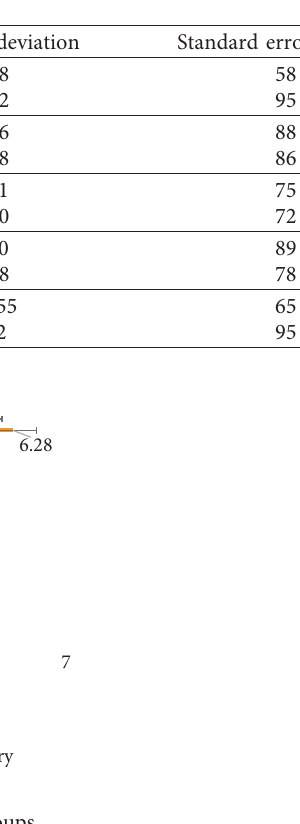
Table 1: Statistical quantity of groups.